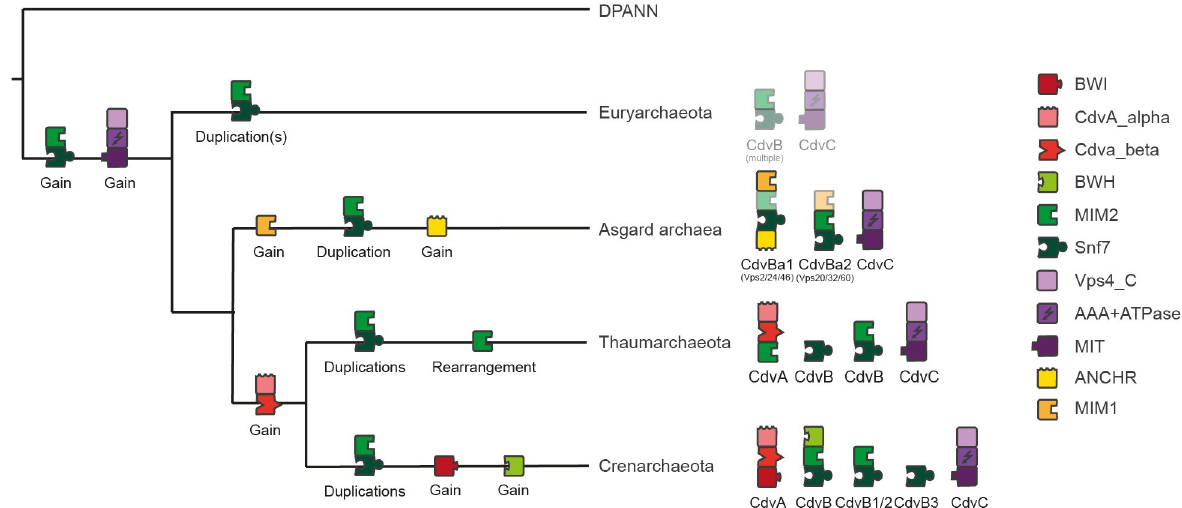
Fig 6. Potential evolutionary development of Cdv/ESCRT machineries. Scenario based on phylogenetic trees ( Figs 2 and S4 ) and maximum parsimony. Domains displayed as blocks as in Figs 2–5.